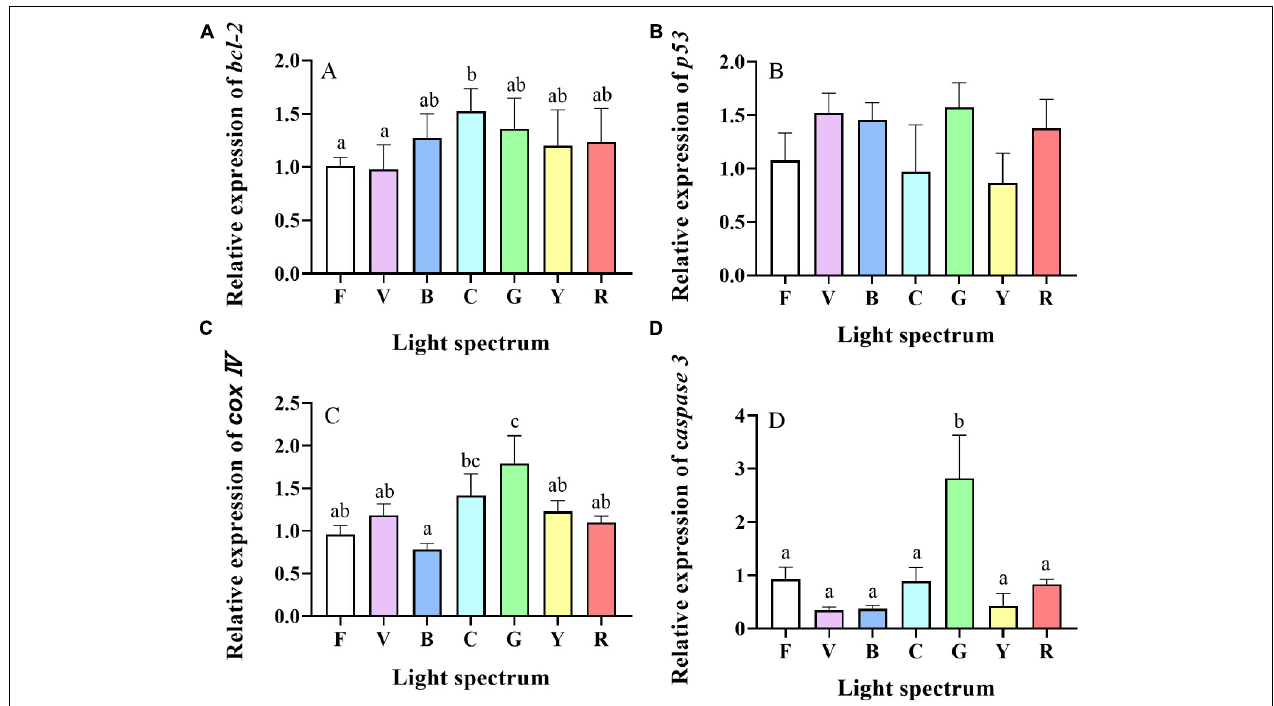
FIGURE 9 | Gene expression of apoptosis-related genes [ bcl-2 (A) , p53 (B) , cox IV (C) and caspase 3 (D) ] in hepatopancreases of S. paramamosain reared under the various light spectrum. Values are expressed as means ± SD ( n = 3, 2 individuals per replicate). F, Full spectrum; V, Violet; B, Blue; C, Cyan; G, Green; Y, Yellow; R, Red. Different superscripts denote significant differences between treatments ( P < 0.05).